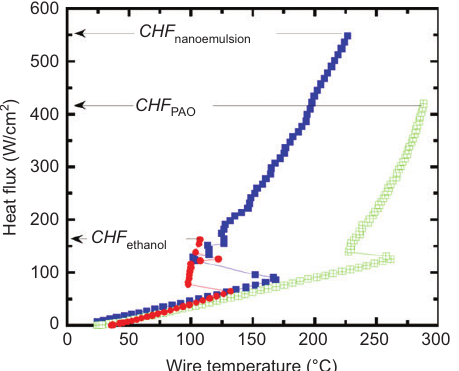
Figure 7 The surface heat flux as a function of the heater tempera- ture for the pure PAO, pure ethanol, and PAO nanoemulsion fluids. These data were measured in a pool boiling setup with an untex- tured heater surface (Pt wire, 25.4 μ m in diameter), where the bulk liquid was at atmospheric pressure and room temperature (25 ° C, not at a saturated state). The CHF is determined within an accuracy of